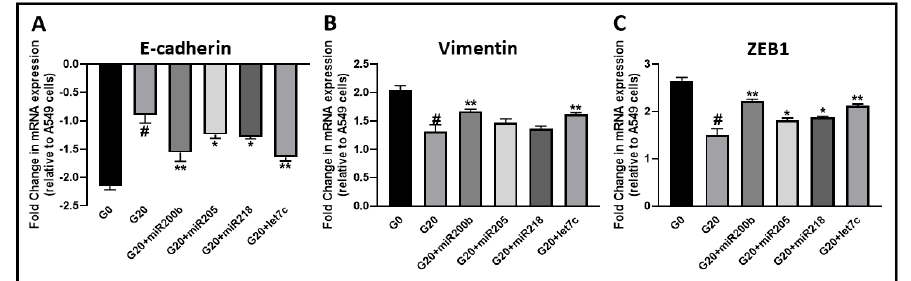
Figure 5. Expression of EMT markers. Expression of epithelial marker E-cadherin ( A ) and mesenchymal markers vimentin ( B ) and ZEB1 (Zinc Finger E-Box Binding Homeobox 1) ( C ) was measured in A549M cells, relative to parental A549 cells. G0: control untreated cells, G20: cells treated with 20 μ M garcinol for 72 h, G20+miR-200b: cells treated with 20 μ M garcinol for 72 h after transfections with anti-miR-200b, G20+miR-205: cells treated with 20 μ M garcinol for 72 h after transfections with anti-miR-205, G20+miR-218: cells treated with 20 μ M garcinol for 72 h after transfections with anti-miR-218, G20+let7c: cells treated with 20 μ M garcinol for 72 h after transfections with anti-Let-7c. # p < 0.01, compared to G0, * p < 0.05, relative to G20, ** p < 0.01, relative to G20.